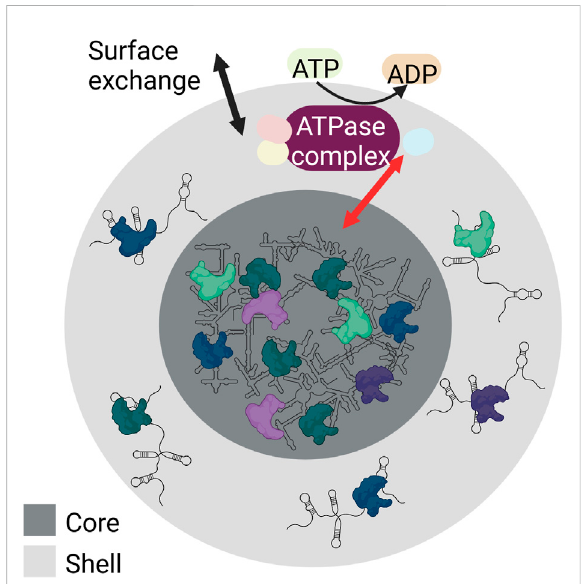
FIGURE 3 Schematic showing the internal structure and LLPS of RNA granules.RNAgranuleshaveacore(darkgrey)madeofcondensed RNA-RNA and RNA-protein complexes, and a shell (light grey) containing RNA-RNA and RNA-protein complexes characterized by weak interactions. Both the shell and the core of the RNA granules build a dynamic system. Both surface exchange (black arrow) and core-shell transitions are possible (red arrow). These are modulated by numerous RNA-protein interactions and require ATP hydrolysis (yellow) as various ATPase complexes (purple) are involved that regulate various steps of granule assembly and stability. Created with